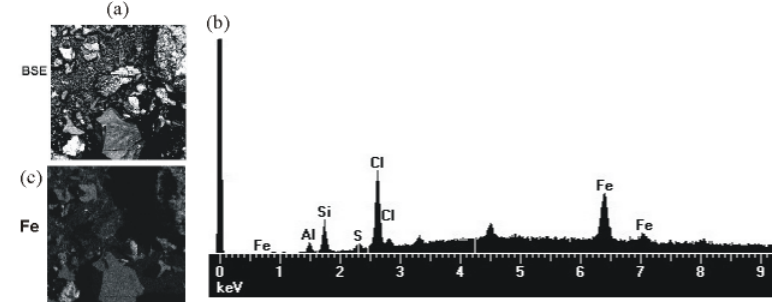
Figura 6. Presença de ferro em ácido húmico (AH) isolado de vermicomposto, obtida por microscopia eletrônica de varredura. (a) imagem em backscattered elétrons (BSE) da amostra de AH; (b) espectro obtido por microscopia analítica, utilizando detector de energia dispersiva de raios X, indicando a presença de ferro no AH; (c) distribuição do ferro na amostra de